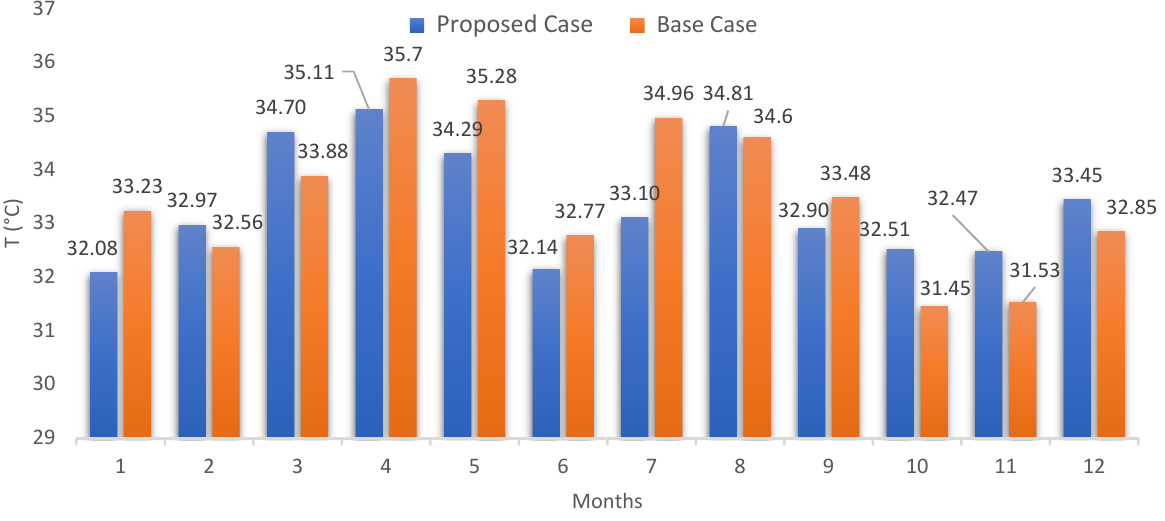
Figure 10. Monthly results of the operative temperature for the selected building, only for occupied hours. Own elaboration.